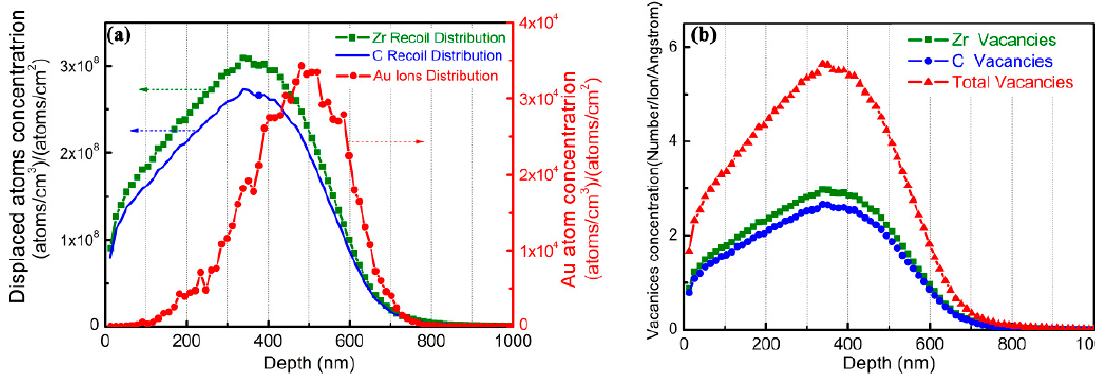
Figure 1. Distribution of ( a ) displaced Zr and C atoms and ( b ) Zr vacancies and C vacancies in ZrC irradiated by a beam of 10,000 four MeV Au ions calculated with SRIM.